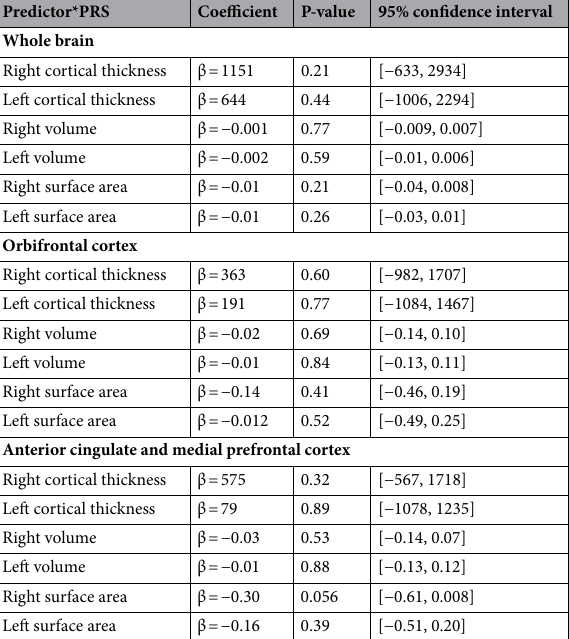
Table 5. Results for brain-gene interactions between PRS for BMI and brain parameters on BMI in SHIP-2. Analyses are adjusted for ICV, age_2, sex and age*sex interaction, volume refers to GMV.